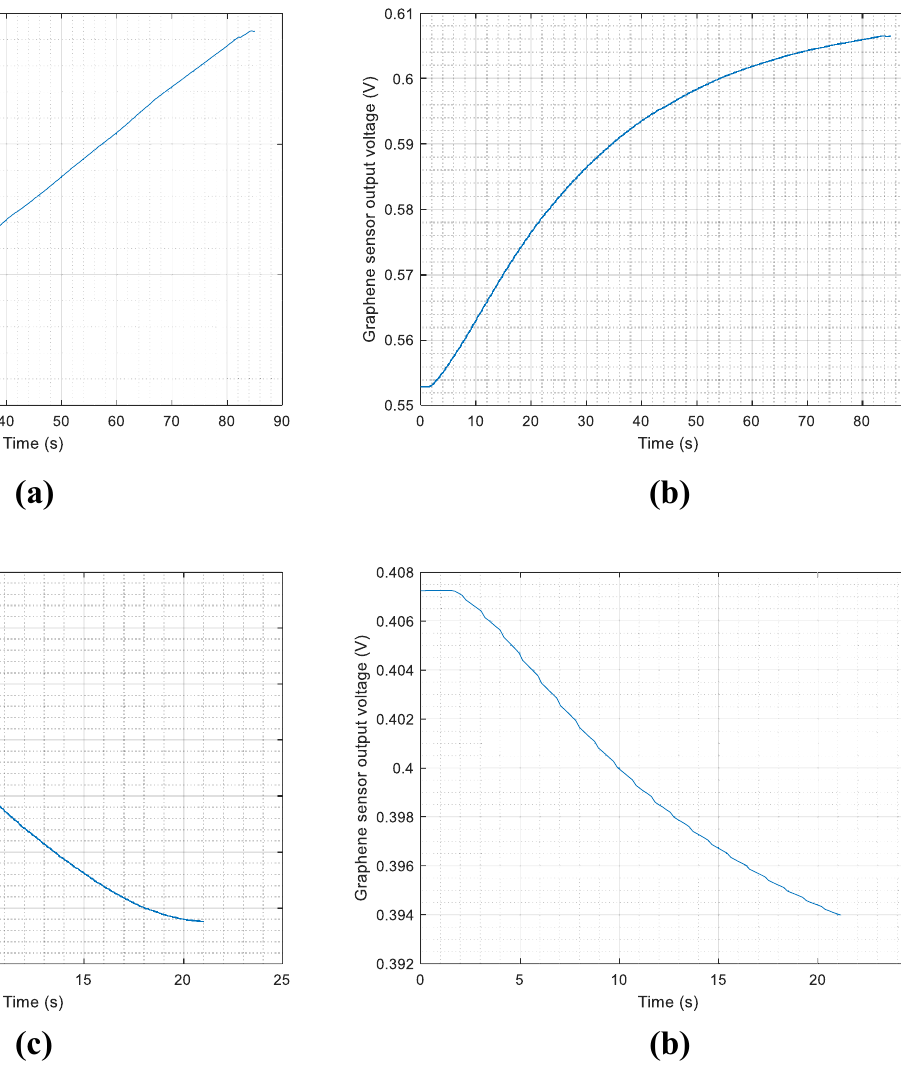
Fig. 13 Strain measurement obtained from a strain gauge a and graphene sensor output voltage b for a normal tensile load applied to a GFRP sample with embedded graphene sensor, and a normal